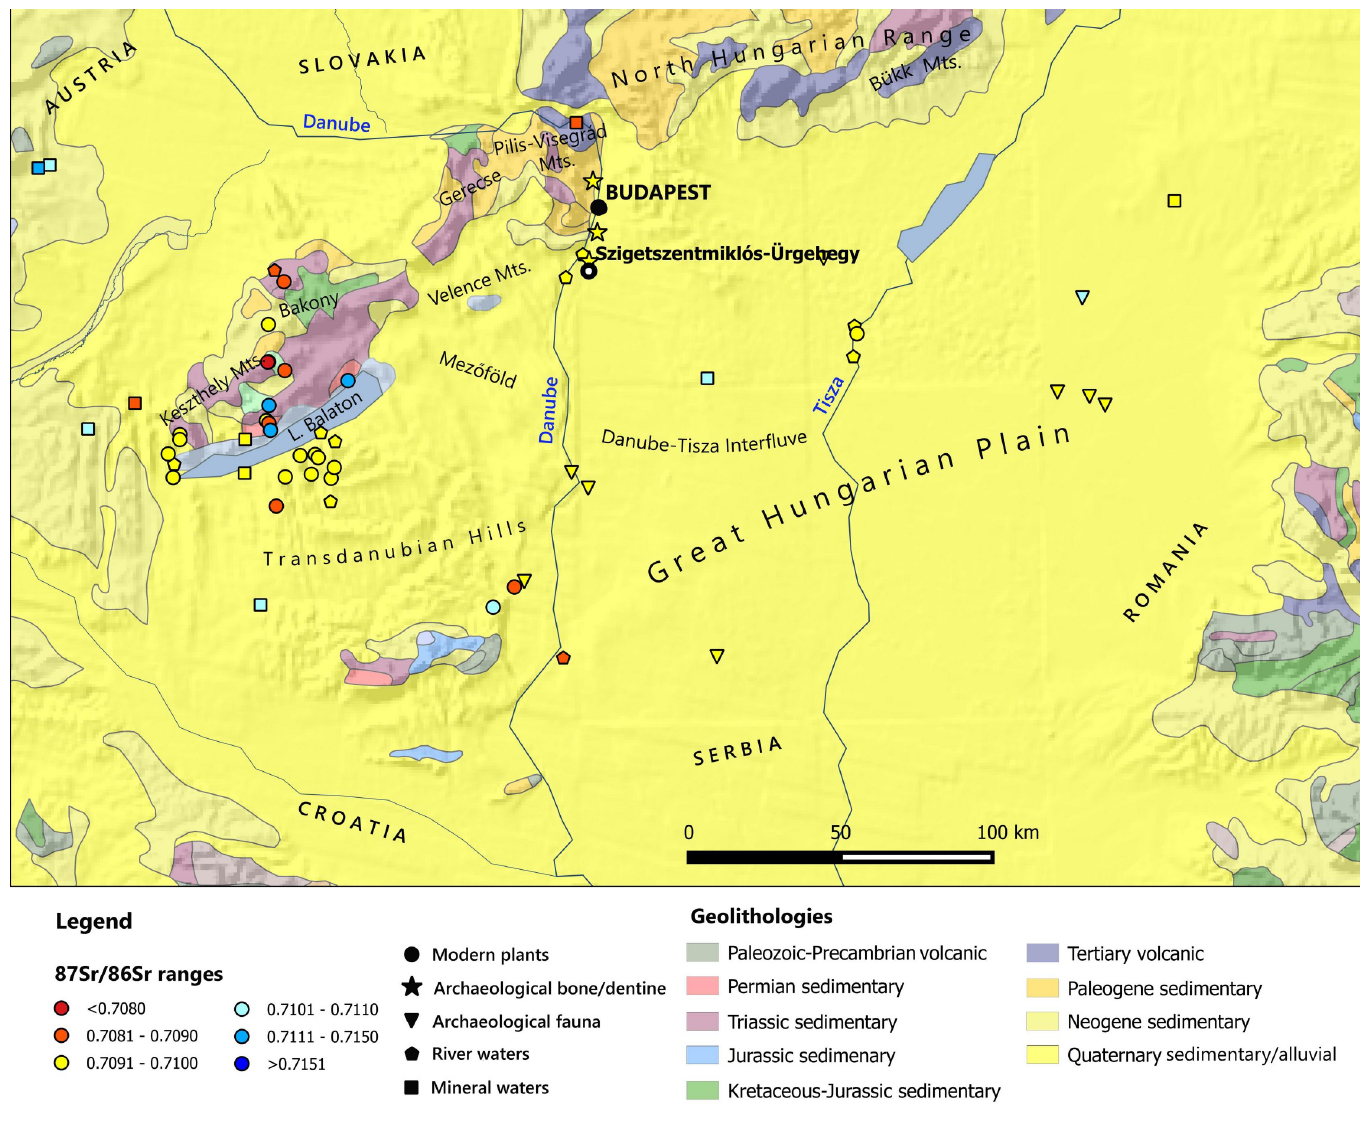
Fig 3. Location of Szigetszentmiklo ´ s-U¨rgehegy cemetery and of the biologically available strontium baselines reported in literature [109–118]. The geological map is constructed by using public domain wms data downloadable from https://certmapper.cr.usgs.gov/data/apps/world-maps/, which are of Public Domain. Credit: U.S. Geological Survey, Department of the Interior/USGS, U.S. Geological